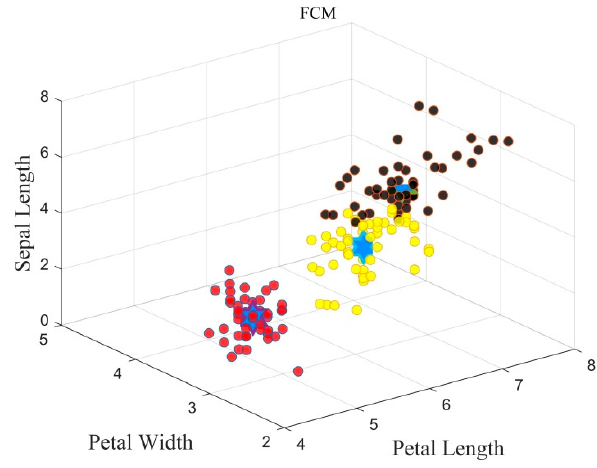
Figure 2. Standard dataset results from FCM. (The black solid dot denotes the Iris-verginica. The red solid dot denotes the Iris-setosa, and the yellow solid dot denotes the Iris-versicolor.)